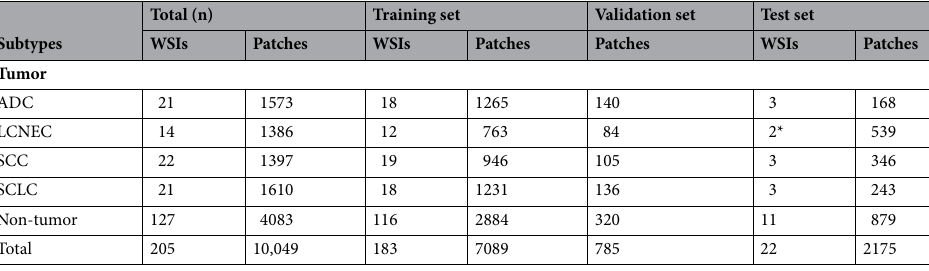
Table 1. Summary of number of whole slide images (WSIs) and patches in the dataset: training, validation, and test set among four lung cancer subtypes and a negative case. ADC adenocarcinoma, LCNEC large cell